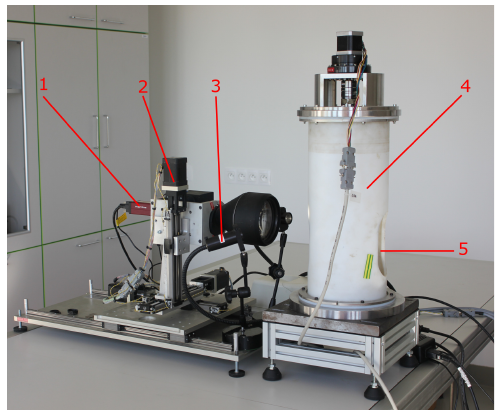
Figure 2. 1 - camera, 2 - positionable table, 3 - LED source, 4 - loading device, 5 - place for specimen